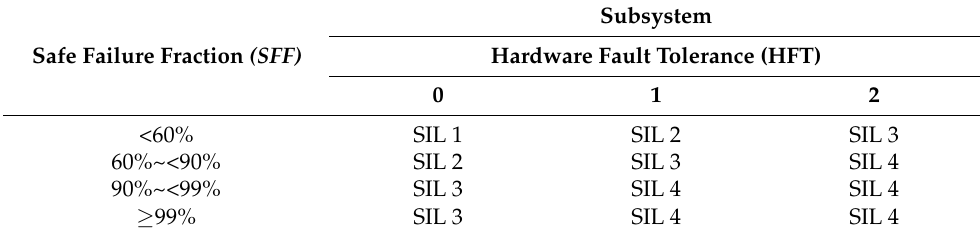
Table 9. Hardware safety integrity: Architectural constrains on Type A safety-related subsystems [17].